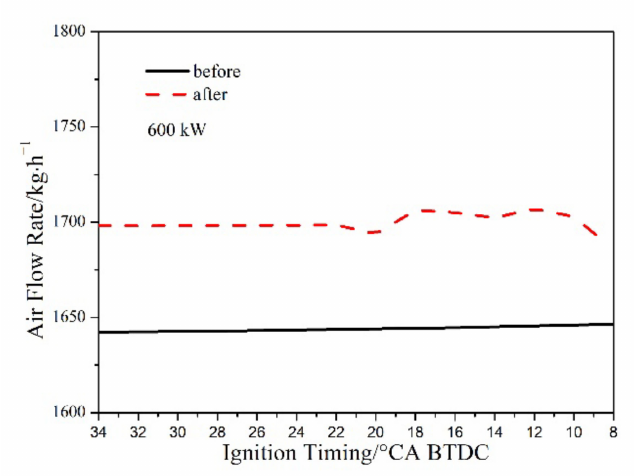
Figure 15. Comparison of intake pipe flow before and after improvement.